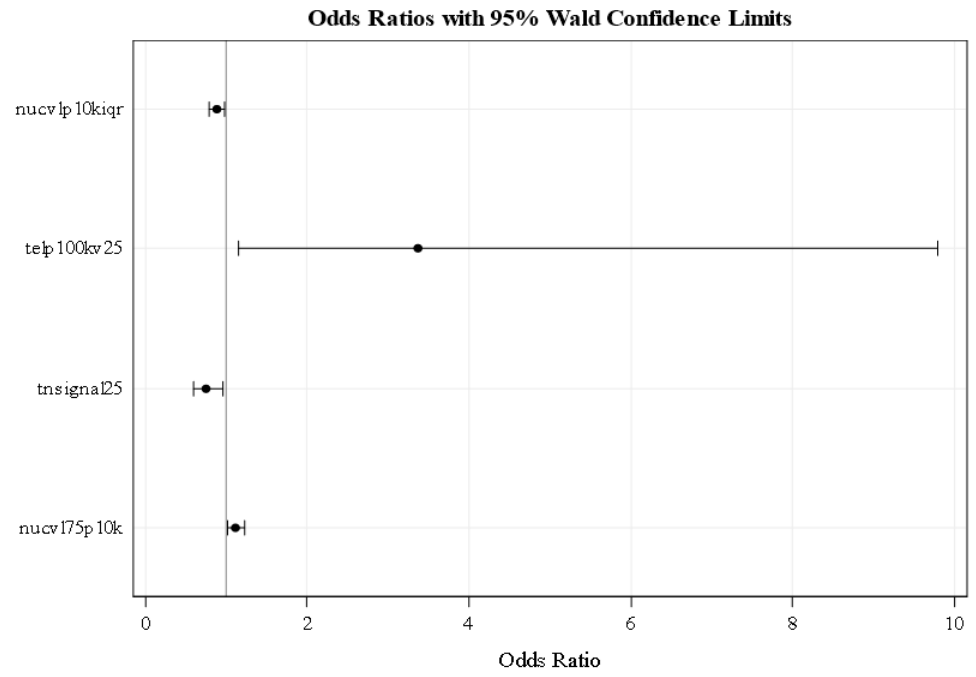
Figure 3. Logistic regression modeling identified four parameters that enable the distinction of stable vs. aggressive disease as measured by 3D telomere profiling in patients with intermediate risk prostate cancer. At a confidence level of 95%, patients with values < 1 are considered to be with stable disease at the time point of the analysis, while patients with values > 1 are considered to be with aggressive disease. The wide 95% confidence interval (CI) observed for telp100kv25 indicates that this predictor is less accurate than the other three that all display a very narrow 95% CI. Abbreviations in this figure: iqr: interquartile range (the difference between the 75th percentile and the 25th percentile); nucvolp10kiqr: nuclear volume (10 × interquartile); telp100kv25: telomeres per nuclear volume (100 × nuclear volume 25th quartile), tnsignal25: total number of telomere signals (25th quartile), nucvol75p10k: nuclear volume (10 × 75th quartile).